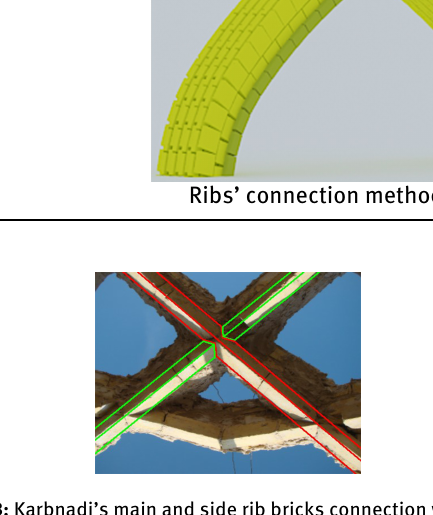
Figure 3: Karbnadi’s main and side rib bricks connection with dis- crete Mitered joint method